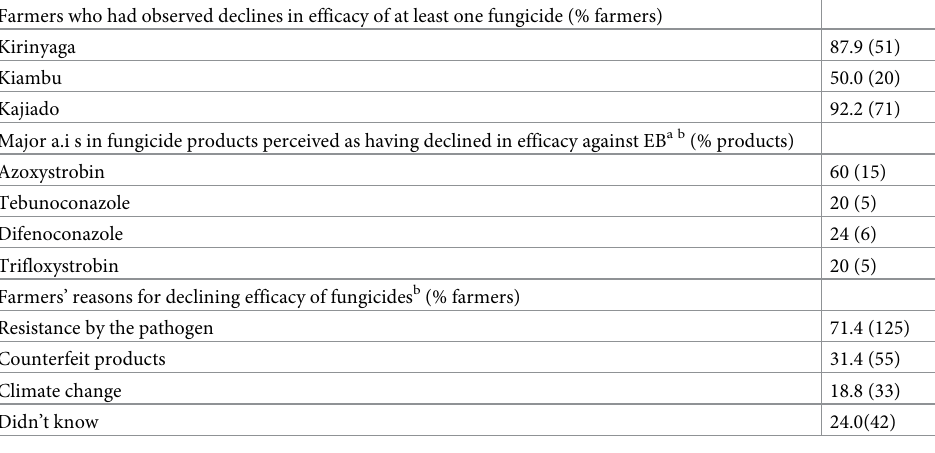
Table 7. Farmers’ perceptions on declining efficacy of some fungicides for Early blight control in surveyed coun- ties, Kenya. Farmers who had observed declines in efficacy of at least one fungicide (% farmers)